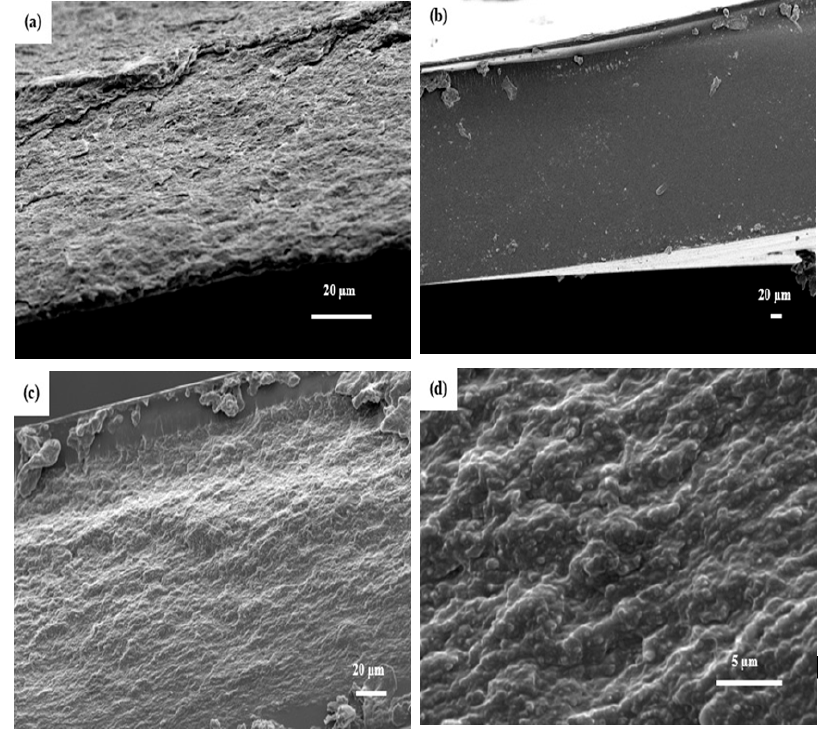
Figure 1. SEM images of fracture surfaces of ( a ) Pure CNF film; ( b ) neat epoxy film; ( c ) 23 wt % CNF/epoxy composite (low resolution); and ( d ) 23 wt % CNF/epoxy composite (high resolution).